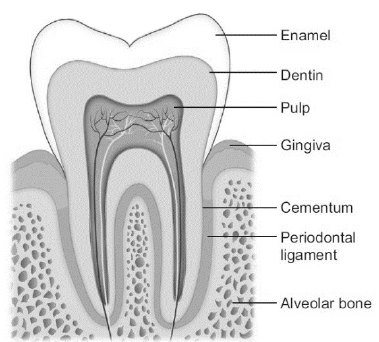
Figure 1. Structure of a tooth and periodontium. Modified from reference [4], with permission from Radiologic Clinics of North America, published by Elsevier,